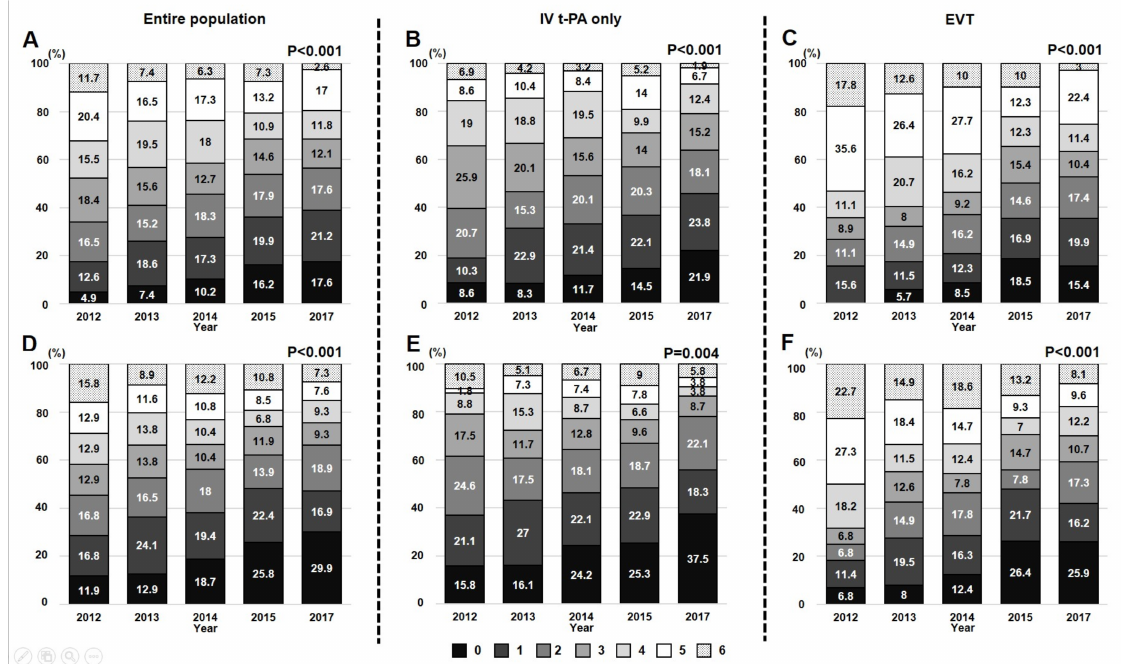
Figure 2. Secular trends in functional outcome at discharge ( A – C ) and after 90 days ( D – F ). Distribution of mRS scores of the entire population (A and D), those who received IV t-PA alone ( B , E ), and those who received EVT with / without IV t-PA ( C , F